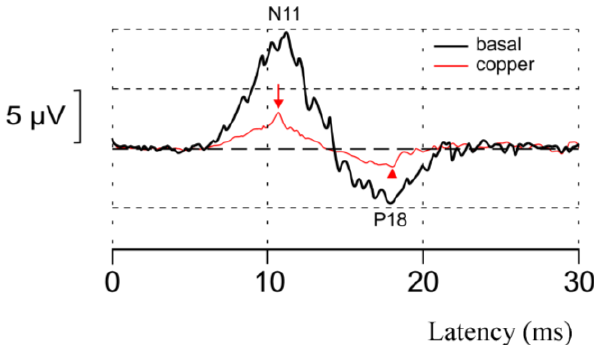
Figure 3. An example of the acute neurotoxic effect of copper in vivo . The spinocerebellar N11-P18 complex (spinocerebellar evoked potentials (SCEP)) at baseline (black trace) and 20 min after the administration of copper (at a concentration of 71.2 µM) in left interpositus nucleus (cerebellum) in an adult Wistar rat maintained under general anesthesia with chloral hydrate. Recordings performed over left cerebellar hemisphere with electrical peripheral stimuli applied on the left tibial nerve. Note the marked decrease of the N11 wave (red arrow) and the P18 wave (red arrowhead), indicating a major depressive effect of copper on cerebellar afferent signals mediated by mossy